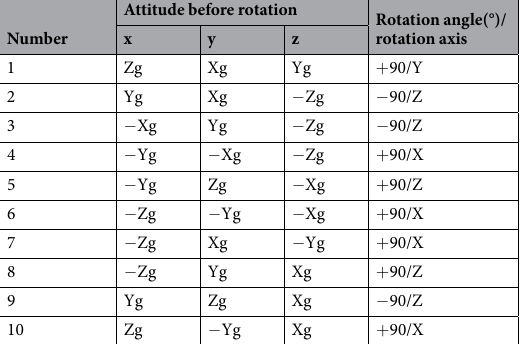
Table 3. The designed 10-position rotations of the evaluation trajectory.